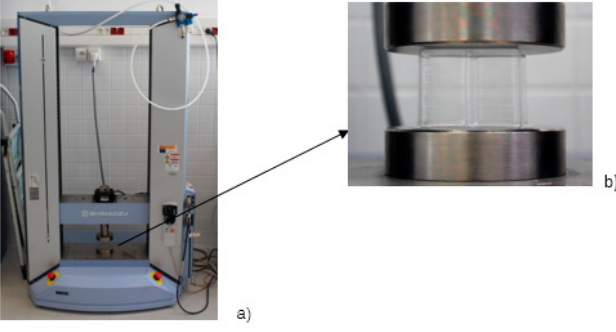
Figure 11. Compression tests: ( a ) general machine view; ( b ) specimen